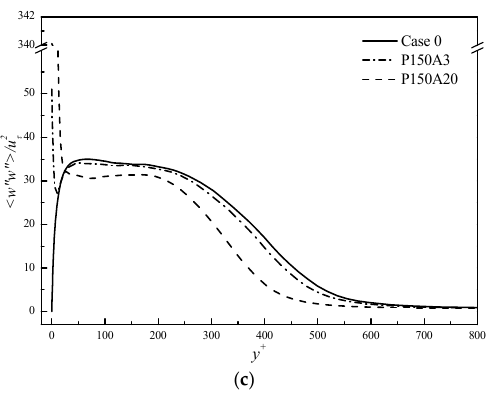
Figure 12. Turbulent velocity fluctuation intensities at x = 40.775: ( a ) Streamwise velocity intensity; ( b ) wall-normal velocity intensity; and ( c ) spanwise velocity intensity.